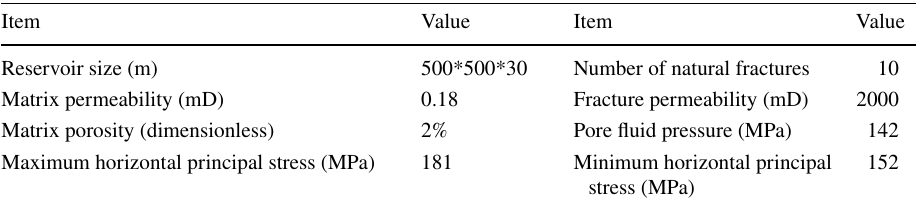
Fig.1 Daily and cumulative output in different